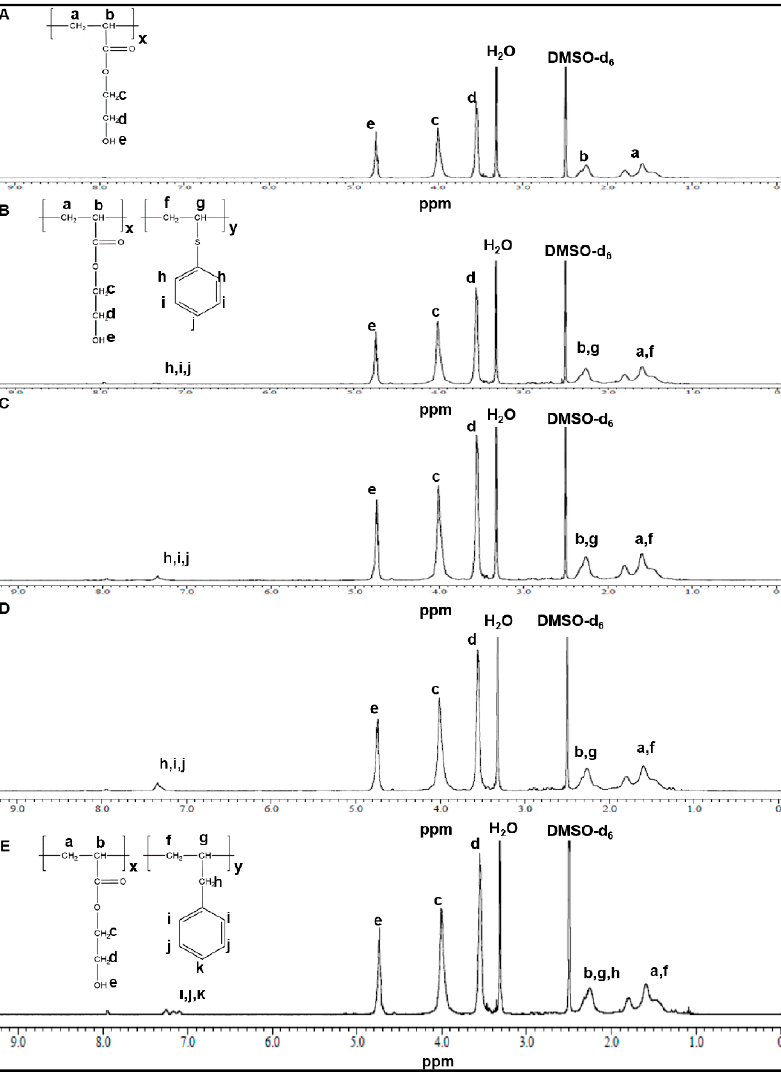
Figure 2. 1 H NMR spectrum of P(HEA- co -PVS)(100 / 0) ( A ), P(HEA- co -PVS)(99 / 1) ( B ), P(HEA- co -PVS)(98 / 2) ( C ), P(HEA- co -PVS)(97 / 3) ( D ), and P(HEA- co -ABZ) ( E ).